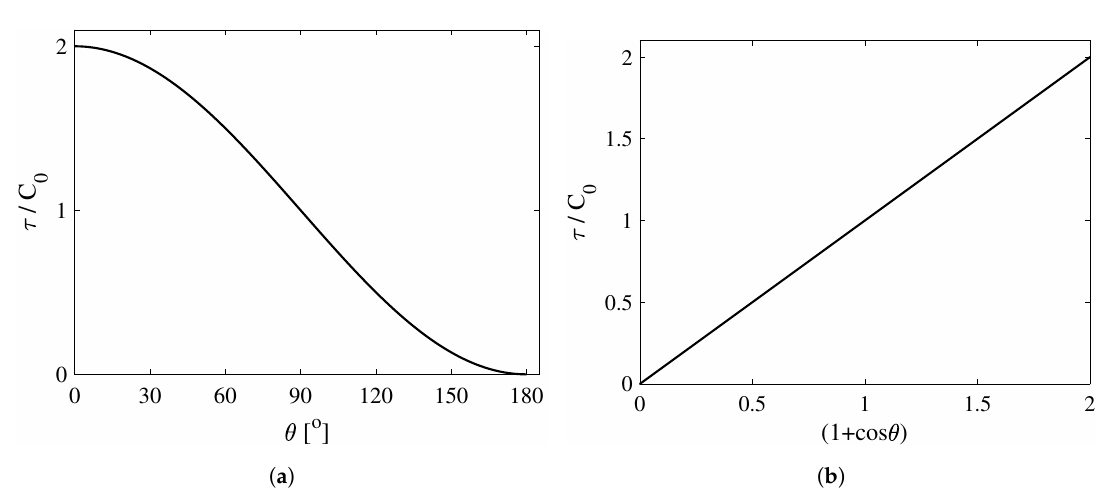
Figure 2. Two forms of the general relation between ice adhesion strength τ and water contact angle θ on a generic surface with properties C 0 ; ( a ) Normalised ice adhesion strength as function of the cosine of the contact angle ( 1 + cos θ ) ; ( b ) Normalised ice adhesion strength as function of the cosine of the contact angle ( 1 + cos θ ) . The relation is described by Equation